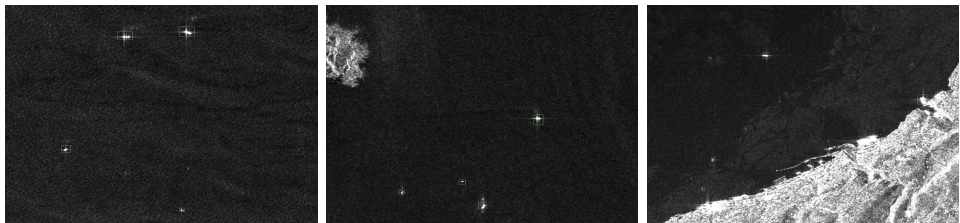
Figure 4. Visualisation of cross sidelobes in the